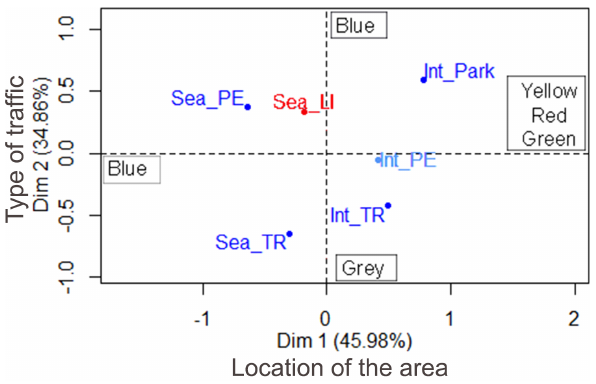
Figure 8: Representation of the correspondence analysis. The colours are reported within rectangles and the types of area are rep- resented with dots (blue: contribution higher than 14.3% (100/7), light blue: contribution lower than 14.3% and red: poor representa- tion in the